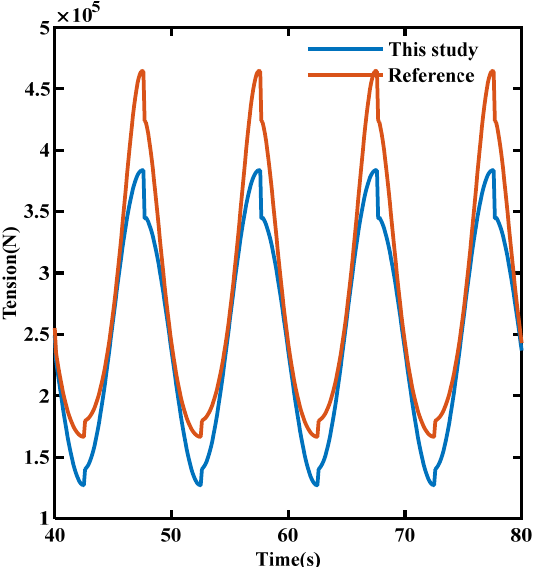
Figure 7. The tension curves of model Equation (24) and the reference